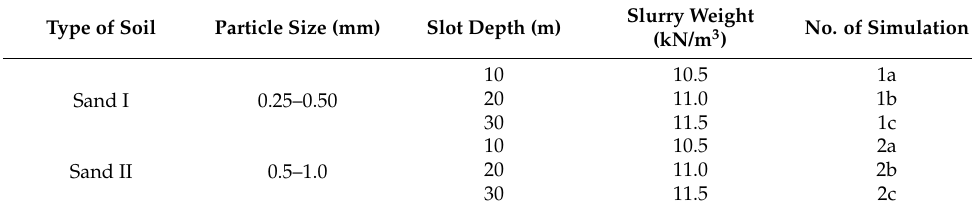
Table 2. Simulation